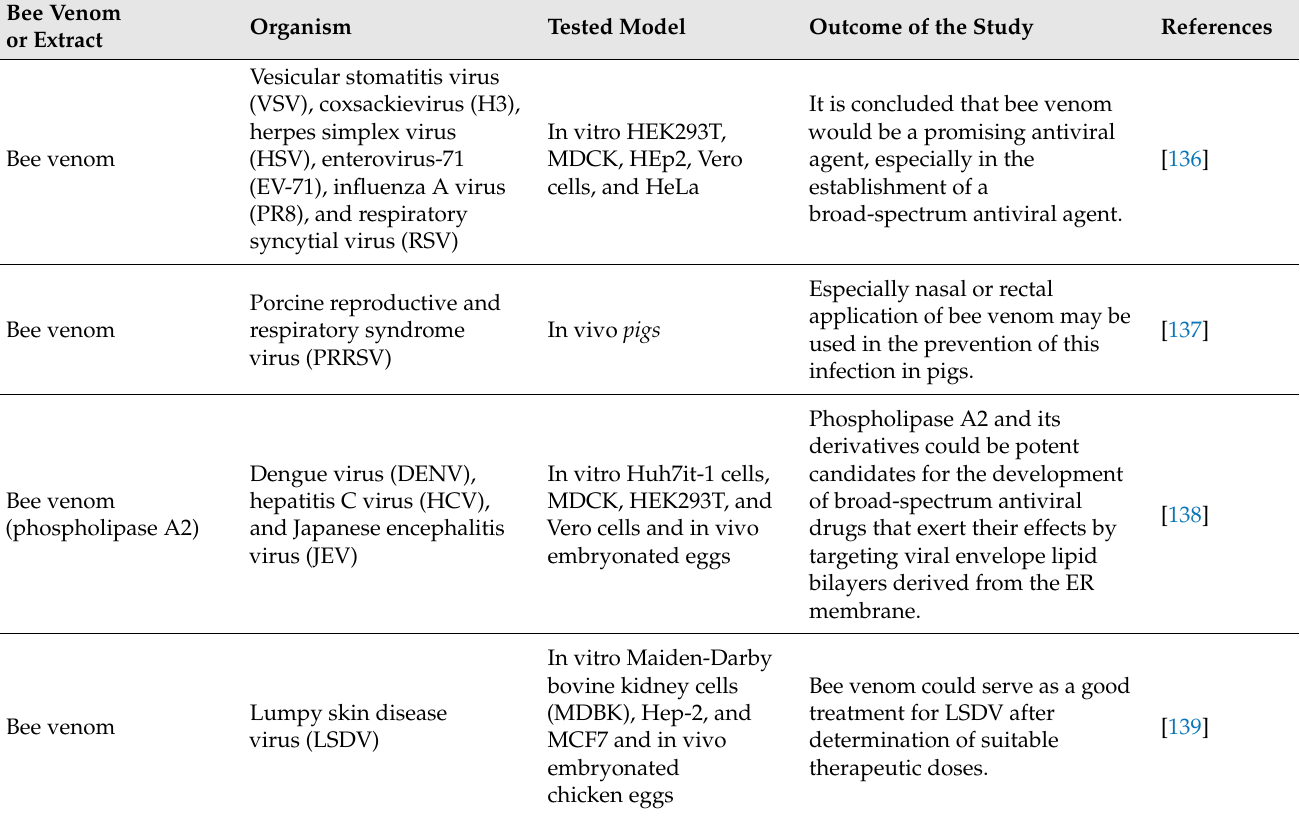
Table 5. Antiviral activities of bee venom and its